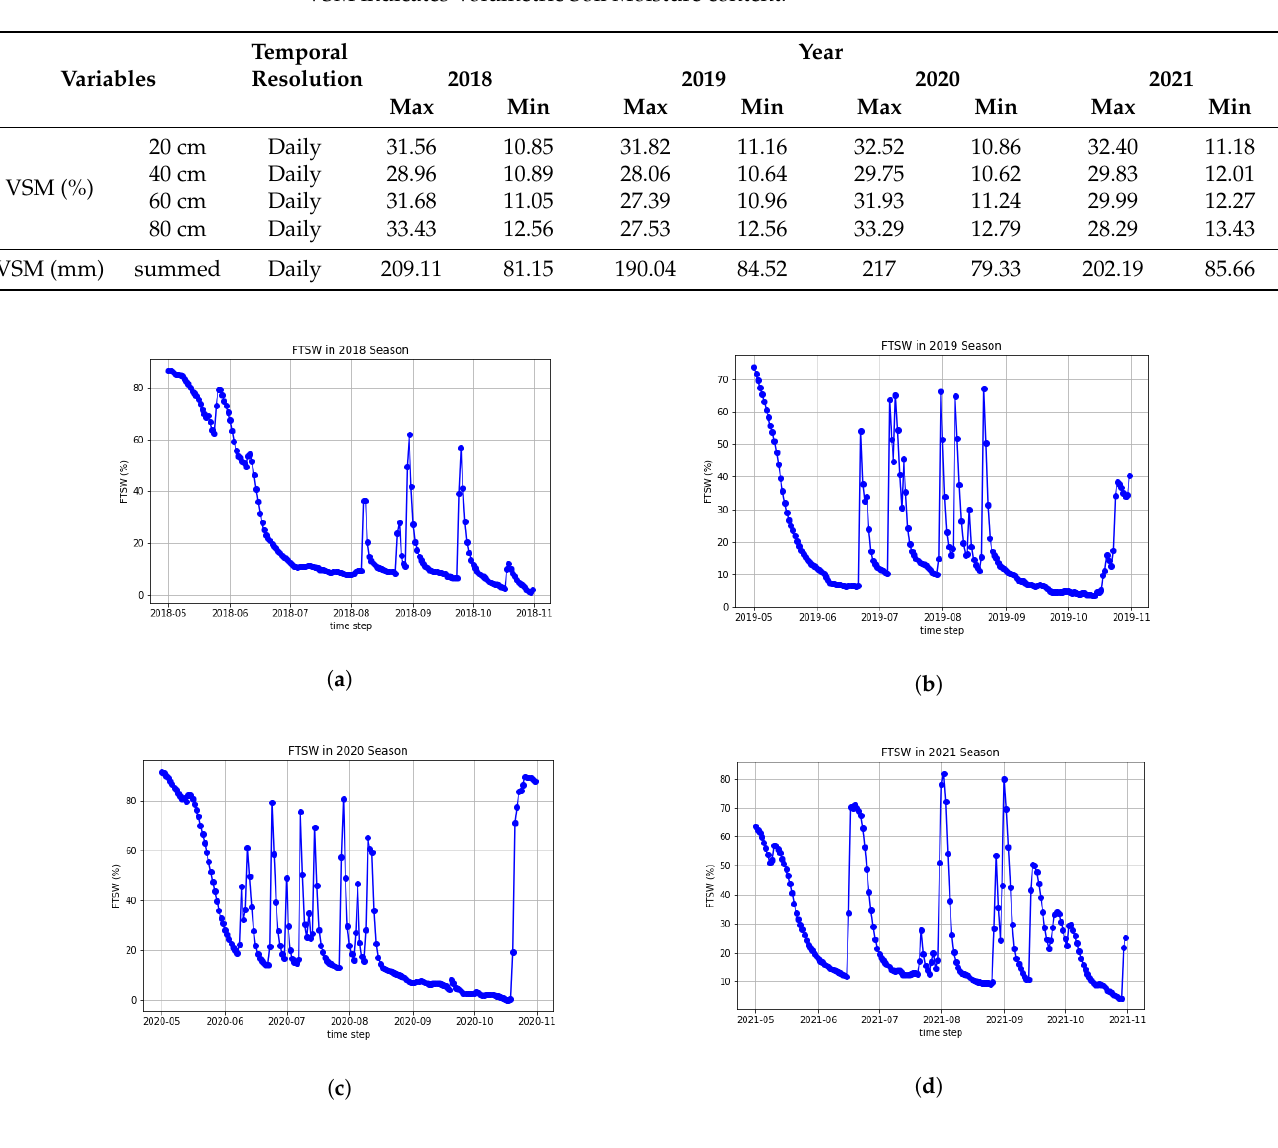
Figure 4. Calculated FTSW of the four seasons for Colinas do Douro from 2018 to 2021. ( a ) FTSW in 2018 season, ( b ) FTSW in 2019 season, ( c ) FTSW in 2020 season, and ( d ) FTSW in 2021